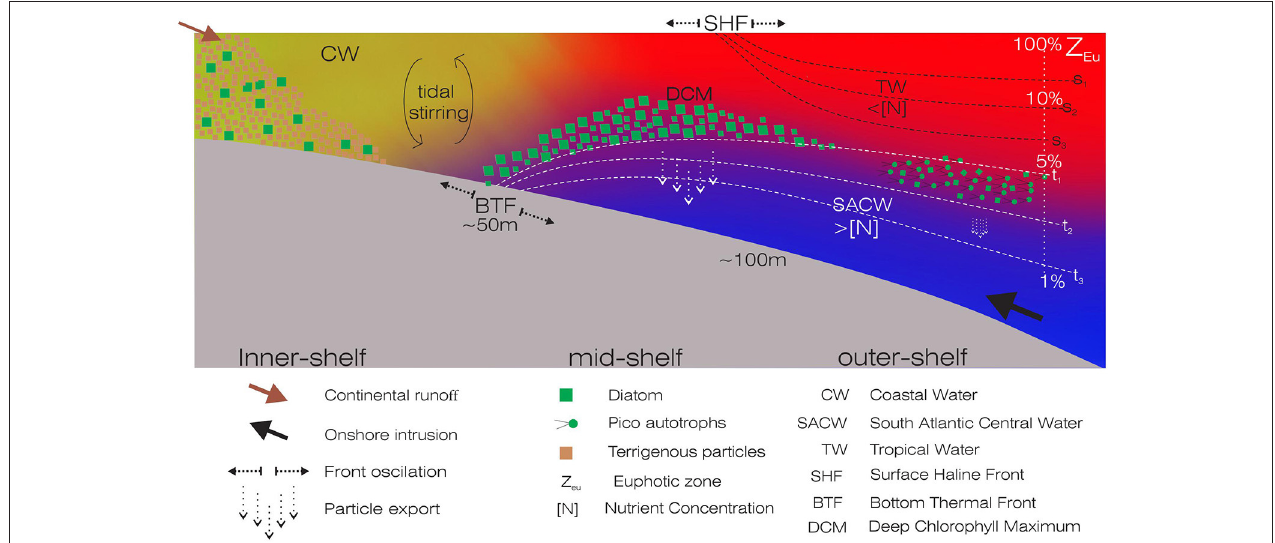
FIGURE 1 | Schematic representation of a typical cross-shelf transect showing the positions of the Surface Haline Front (SHF) and the Bottom Thermal Front (BTF), and the associated biogeochemical processes. The overlying water masses are shown as follows: Coastal Water (CW) in yellow, Tropical Water (TW) in red, South Atlantic Central Water (SACW) in blue. Different arrows represent the continental runoff, onshore intrusion, front oscillations and particle export. Green squares and dots represent autotrophic communities. Redrawn from the Project OCEANOS/CARBOM (Environmental Characterization and Evaluation of Biogenic Ocean Resources from the Brazilian Continental Shelf and the Adjacent Oceanic